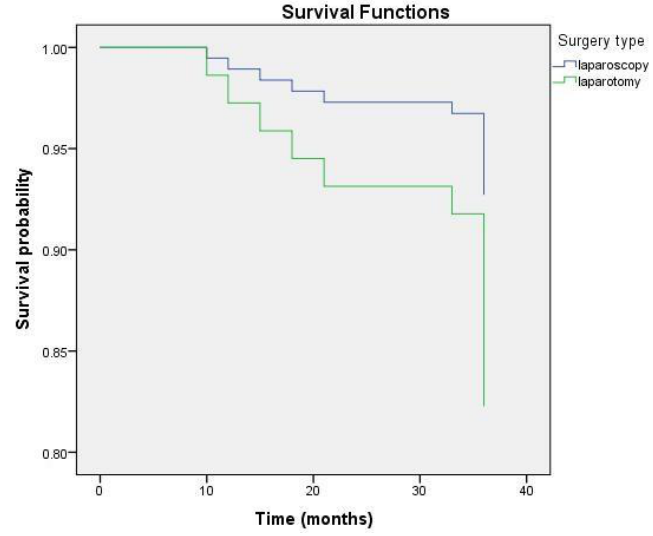
Figure 2. Cox (proportional hazards) regression curves for 3-year OS between laparoscopic and lap- arotomic surgical approach for